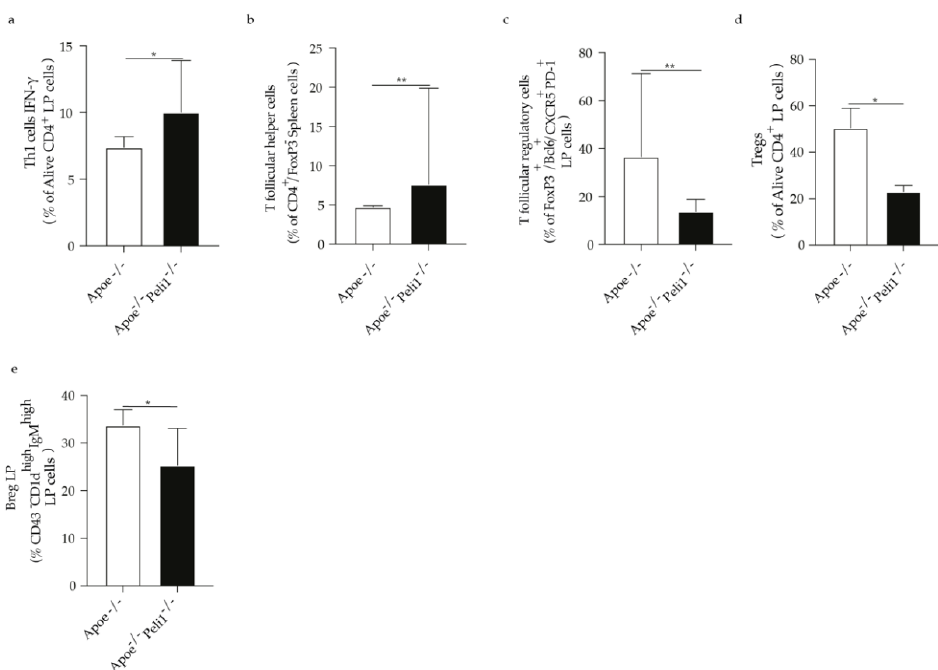
Figure 5. Bar graphs represent the quantification of liquid peritoneal (LP) ( a ) Th1 cells producing IFN- γ; ( b ) Follicular helper T cells; ( c ) Follicular regulatory T cells; ( d ) Tregs cells and ( e ) B reg cells in Apoe −/− and Apoe −/− Peli1 −/− mice on HCD, n = 7 – 8/group. U-Mann Whiney, all data are presented as median with interquartile range with p ≤ 0.05 * and p ≤ 0.01 **.